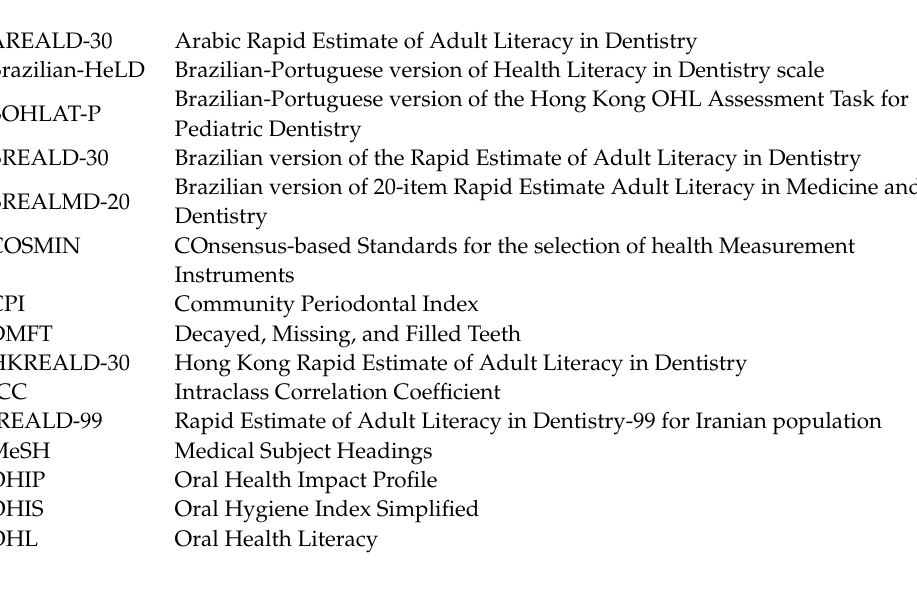
Table S3: Reasons for excluded studies, Table S4: Guidelines for the process of the cross-cultural adaptation of self-reported measures (adapted from Costa et al.), Table S5: Updated criteria for suitable measurement properties, Table S6: Characteristics of oral health assessment instruments, Table S7: Assessment of quality of translation and cross-cultural adaptation of oral health literacy tools into different languages, Table S8: Rating of the measurement properties per language and tool using the criteria for the suitable psychometric properties and Table S9: Methodological Quality Assessment of Studies on Psychometric Properties of the Included Tools using COSMIN risk of bias